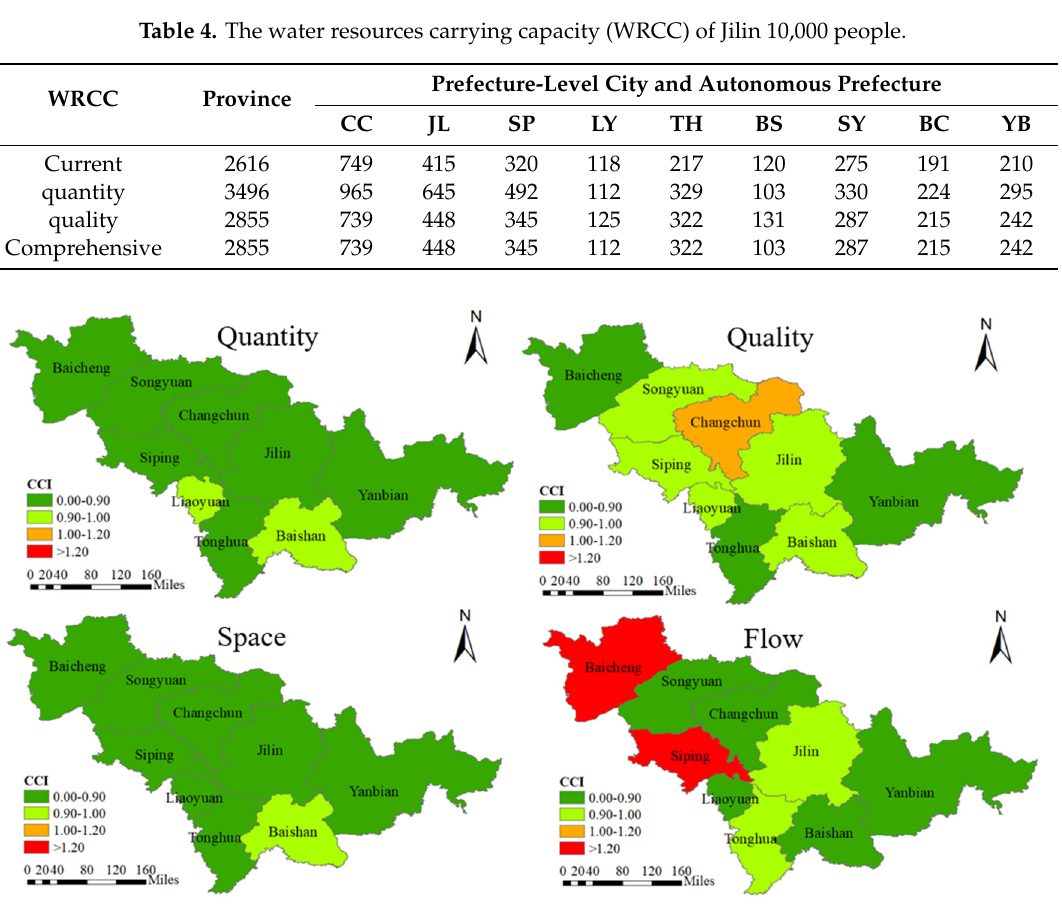
Table 5. Relative errors of the main variables between simulated data and historic data.